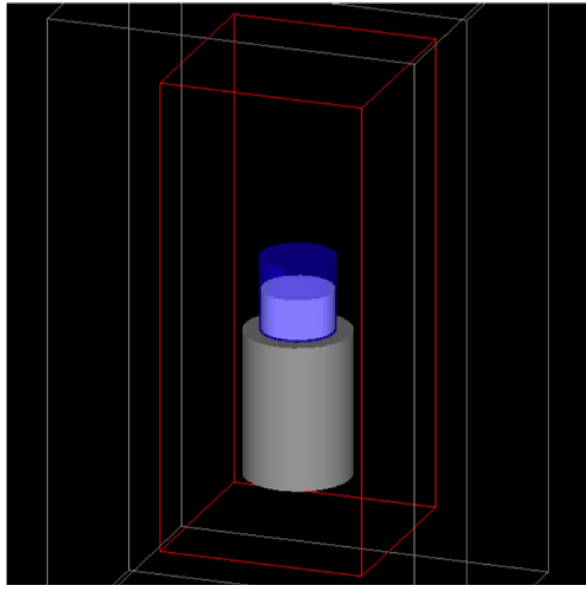
Fig. 5 Simulation showing sample placed on top of the R osebeRRy detector